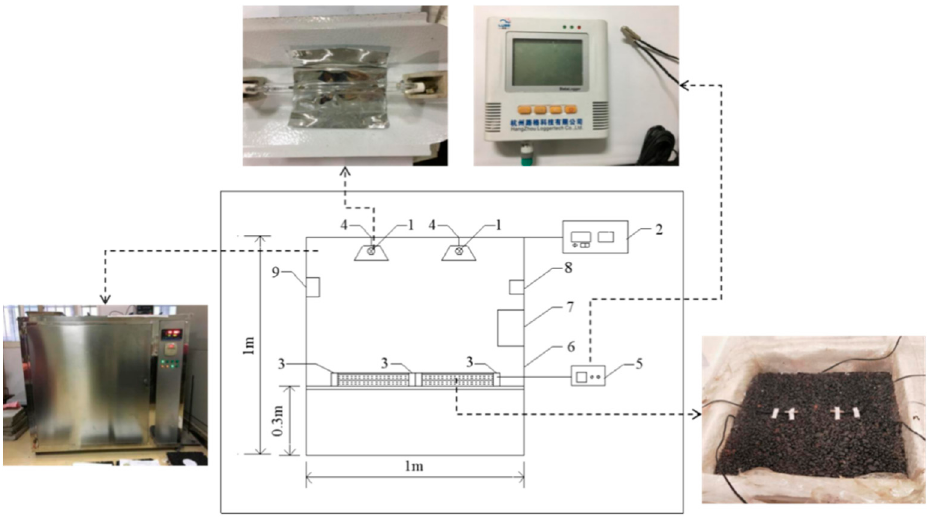
Figure 8. Coating cooling test equipment: 1-Iodine tungsten lamp; 2-Voltage regulator; 3-Thermal insulation layer; 4-Elevating pulley; 5-Temperature collector; 6-Closed box; 7-Heating device; 8-Stirring fan; 9-Humidity controller.